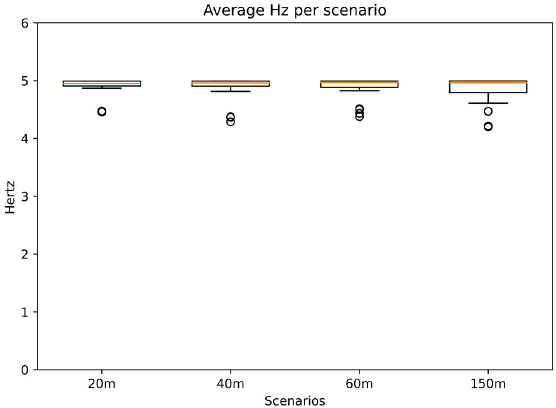
Figure 15. Average Hz of Reference Points per scenario.